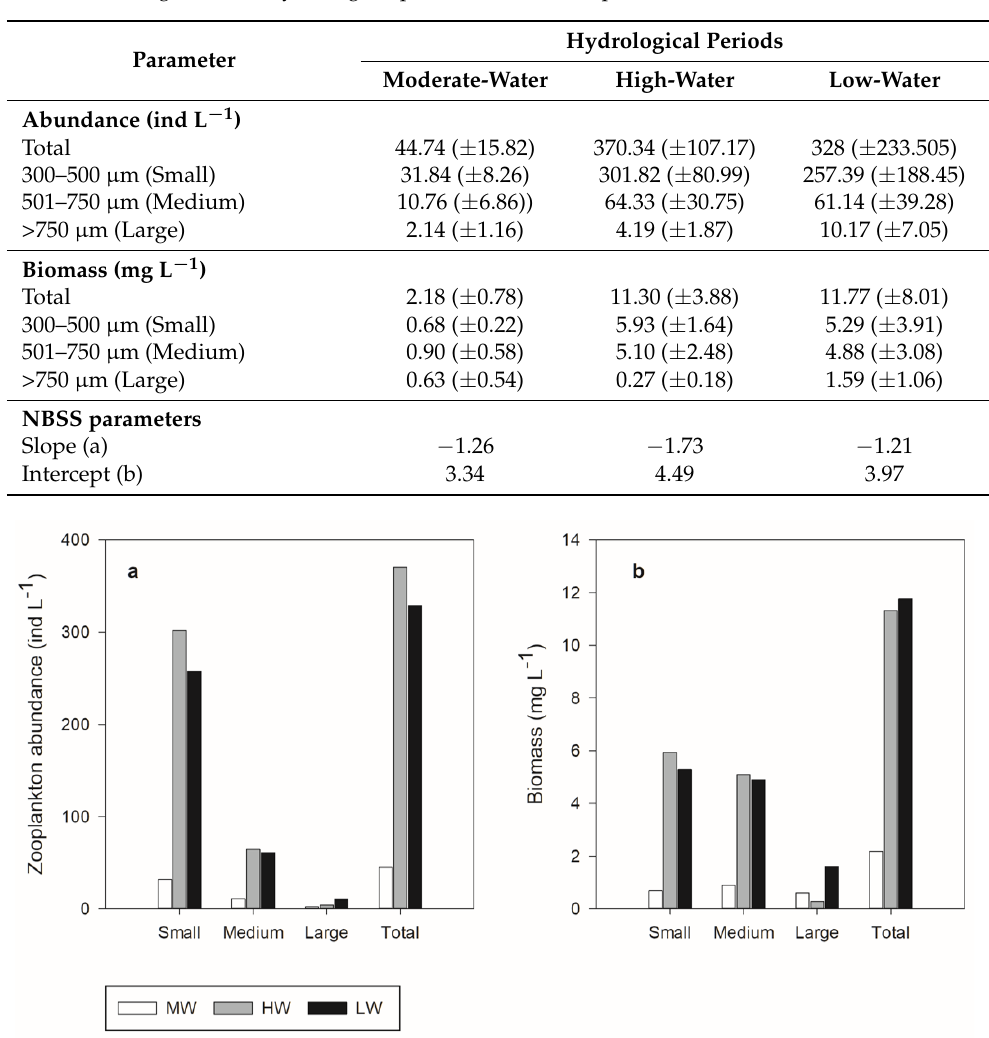
Figure 4. ( a ) Zooplankton mean total abundance and mean abundance of each size class and ( b ) mean total biomass and mean biomass of each size class during the three different hydrological periods: moderate- (MW), high- (HW), and low-water (LW).